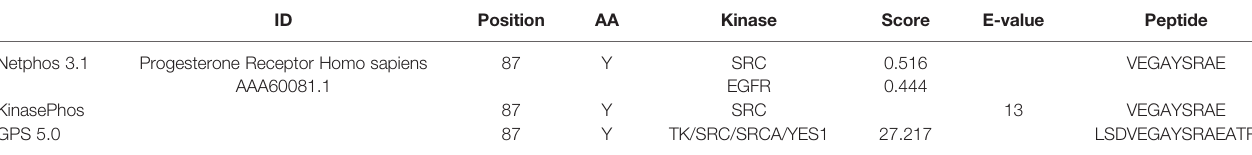
Three different databases to predict phosphorylation sites were used to analyze the potential role of cSrc in PR phosphorylation. One putative tyrosine residue in the amino acid 87of PR was found in three databases: NetPhos 3.1, KinasePhos, and GPS